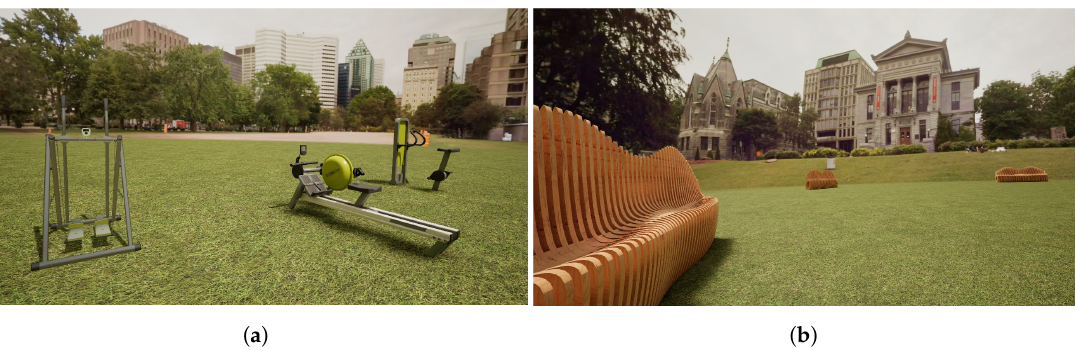
Figure 3. Screenshots of the two use-cases of team Immensive to enhance the place’s usability. ( a ) Fitness island with three gym exercises including matching sounds. ( b ) Relaxing zone with sonic